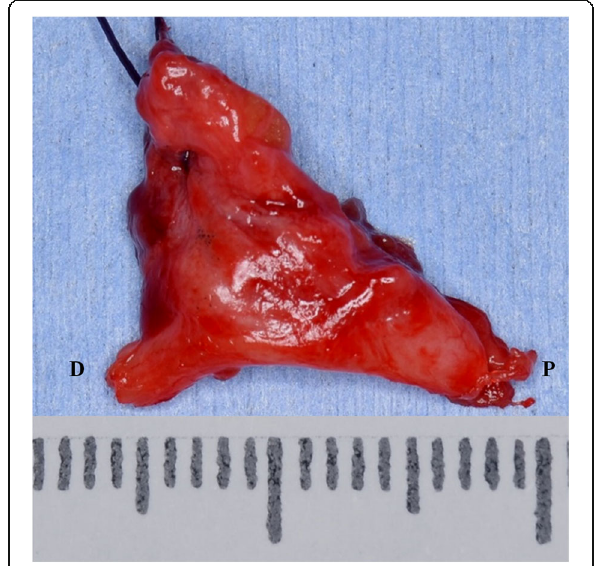
Fig. 1 The granuloma and peripheral neuroma. The removed torn LN and scar tissue was about 14mm length